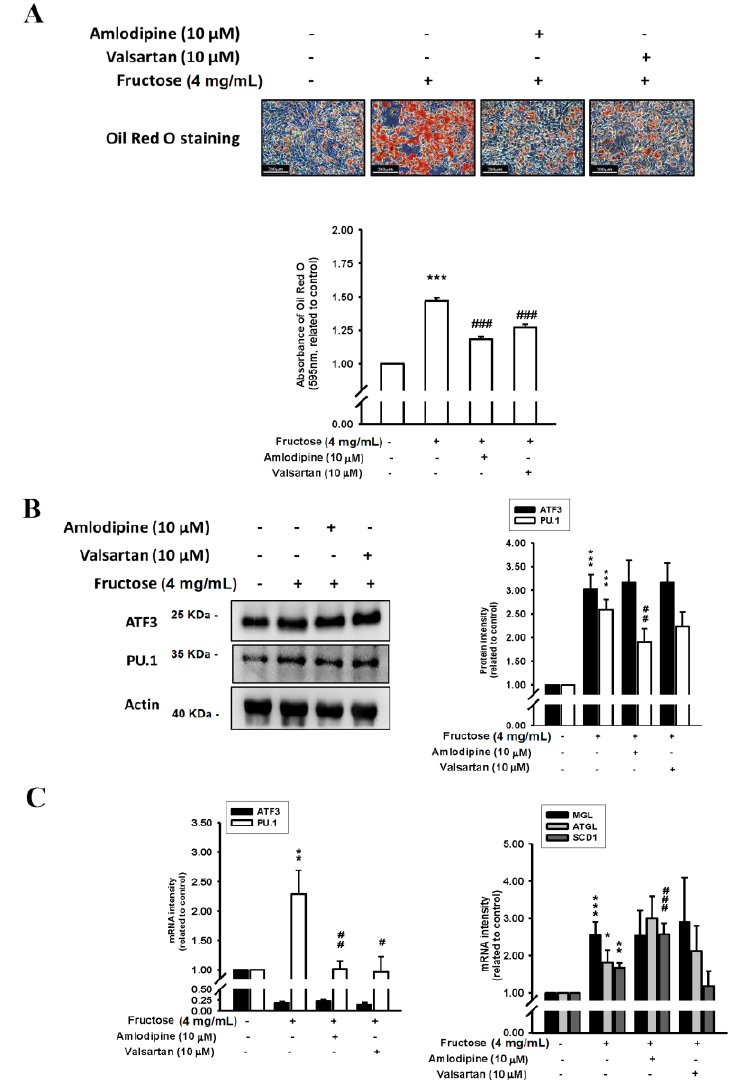
Figure 4. Effects of fructose concentration (4 mg/mL) with and without amlodipine (10 μM) and valsartan (10 μM) on ( A ) triglyceride levels by measuring ORO staining, ( B ) ATF3 and PU.1 protein levels, and ( C ) ATF3, PU.1, MGL, ATGL, and SCD1 mRNA levels in adipocytes in vitro. N = 6. the results from 6 independent experiments in cell culture experiments. Values are presented as mean ± SD. *, **, and *** denote p < 0.05, <0.01, and <0.001 vs. the control groups at Day 7 of the experimental protocol, respectively. #, ##, and ### denote p < 0.05, <0.01, and <0.001 vs. the 4 mg/mL fructose group at Day 7 of the experimental protocol, respectively.